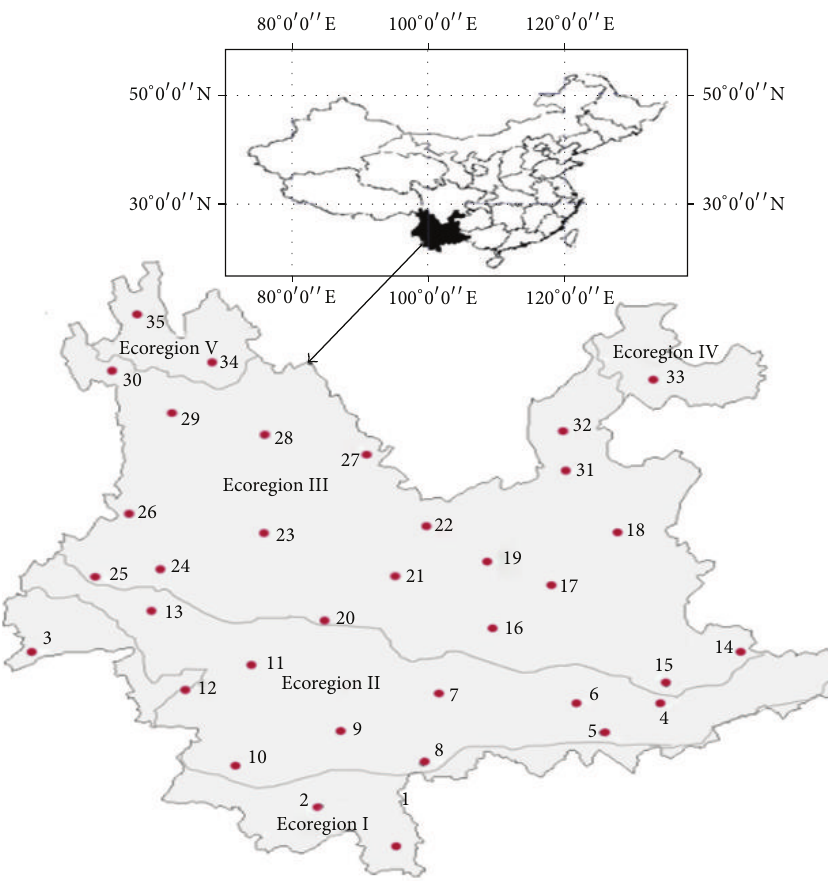
Figure 1: Location of the study area in Yunnan province, southwestern China. The red dots mark the locations of the observation stations with meteorological data for five